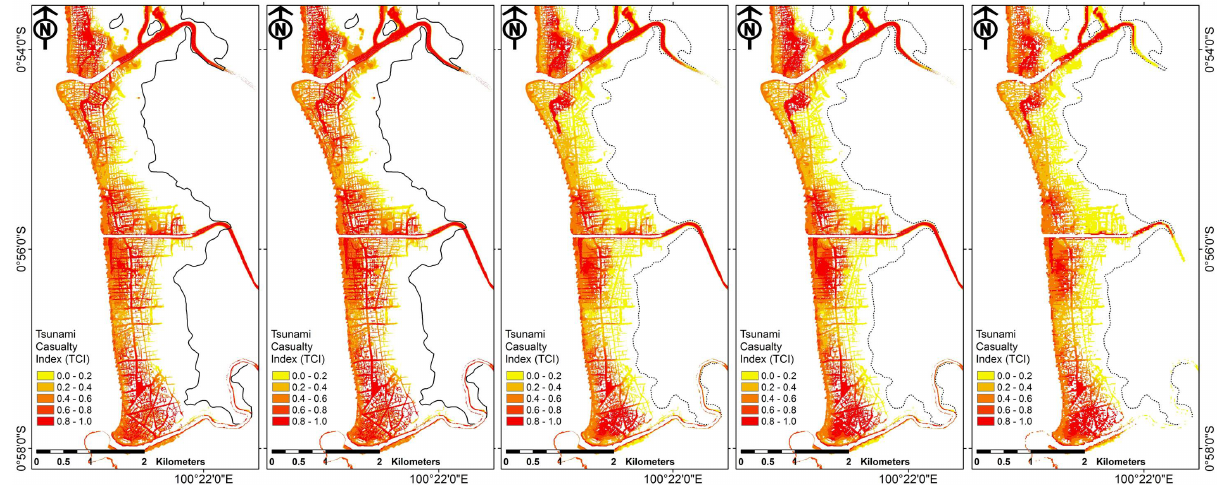
Fig. 17. Comparison between the Road Risk Maps. From left to the right hand side: TM (male), TM (female), ERM (male), ERM (female), and ERM